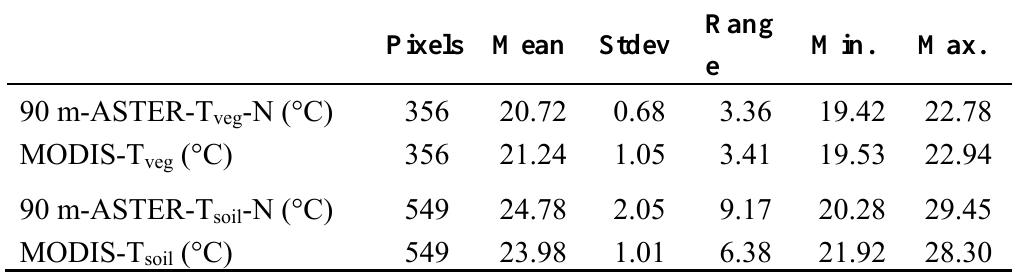
Table 4. Comparisons of MODIS-T ASTER-Ts of pure vegetation and soil on May 9